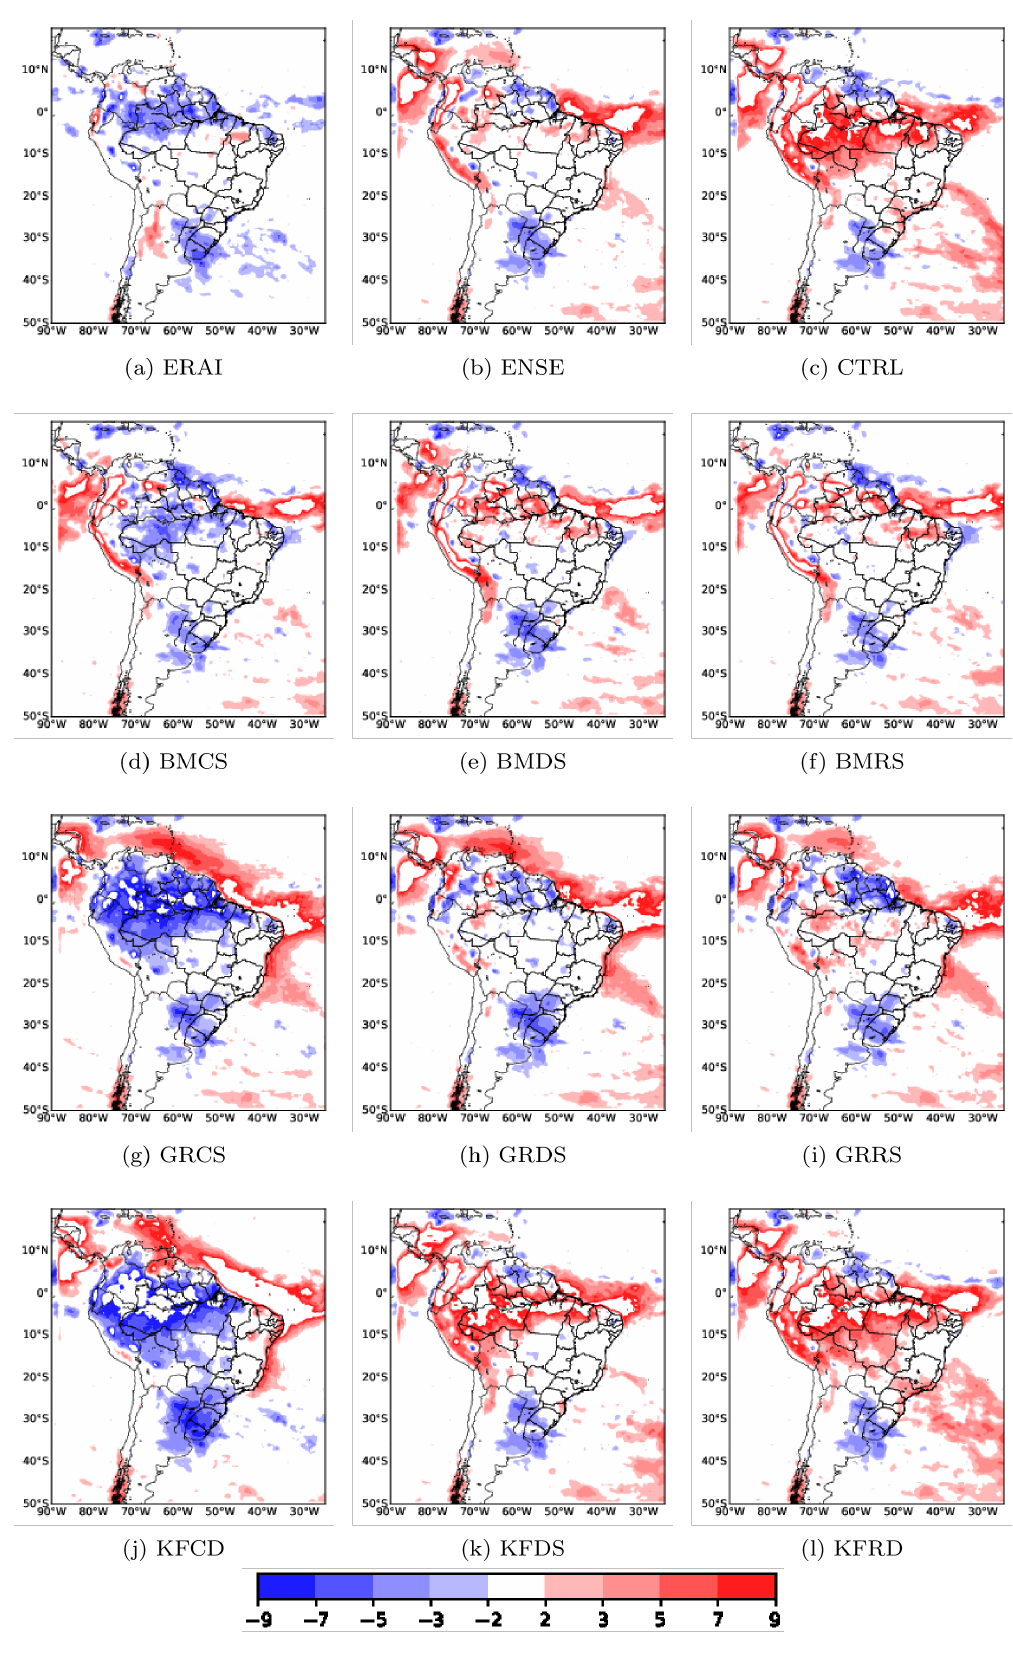
Figure 8. As in Figure 7, but for March–April–May